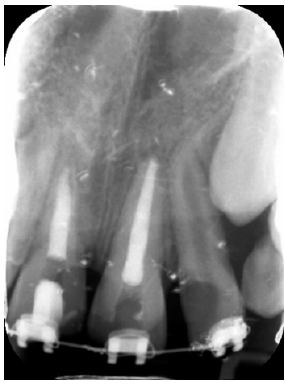
Figure 5. Periapical radiograph demonstrating the conclusion of the endodontic treatment of teeth 11 and 21, respectively.